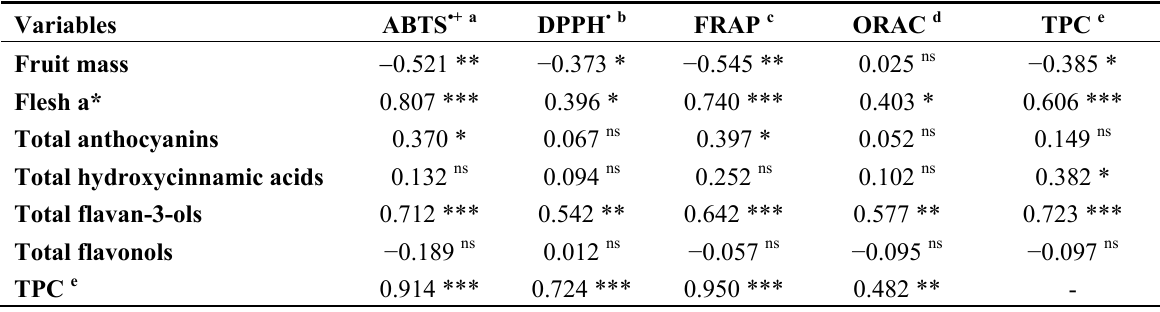
Table 2. Correlations ( r ) between antioxidant capacity and selected parameters for ripe fruit from the second harvest